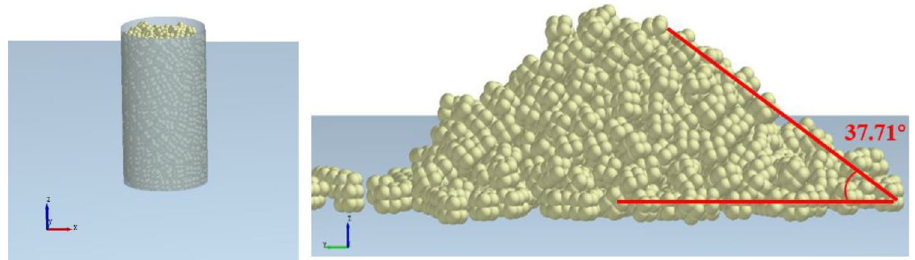
Figure 11. Simulated angle of repose in the EDEM.